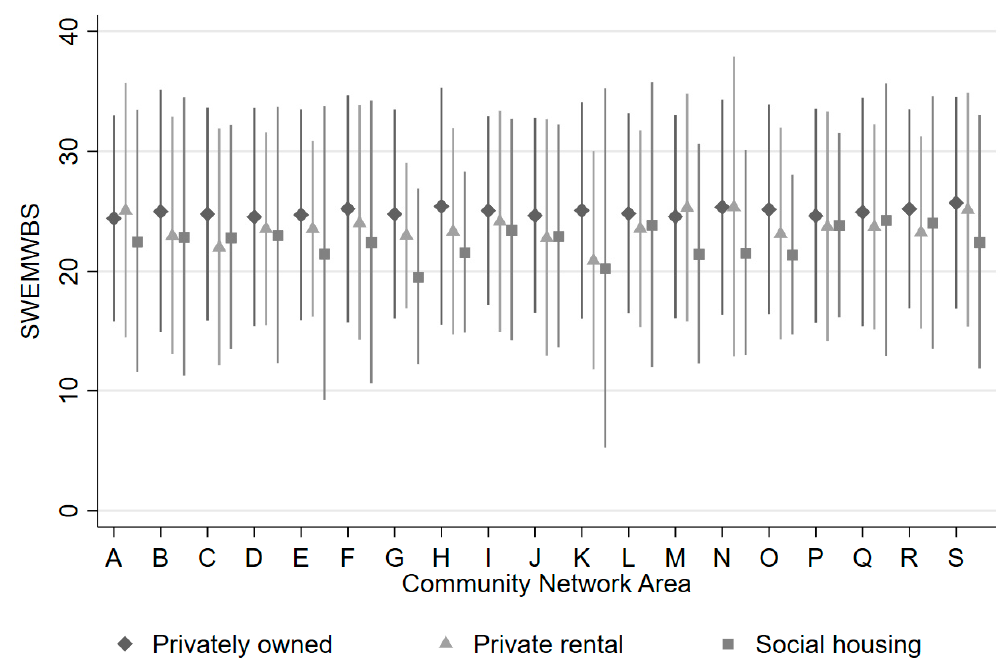
Figure 1. Mean (95% confidence interval) SWEMWBS score by tenure for each of the 19 Cornwall community network areas.